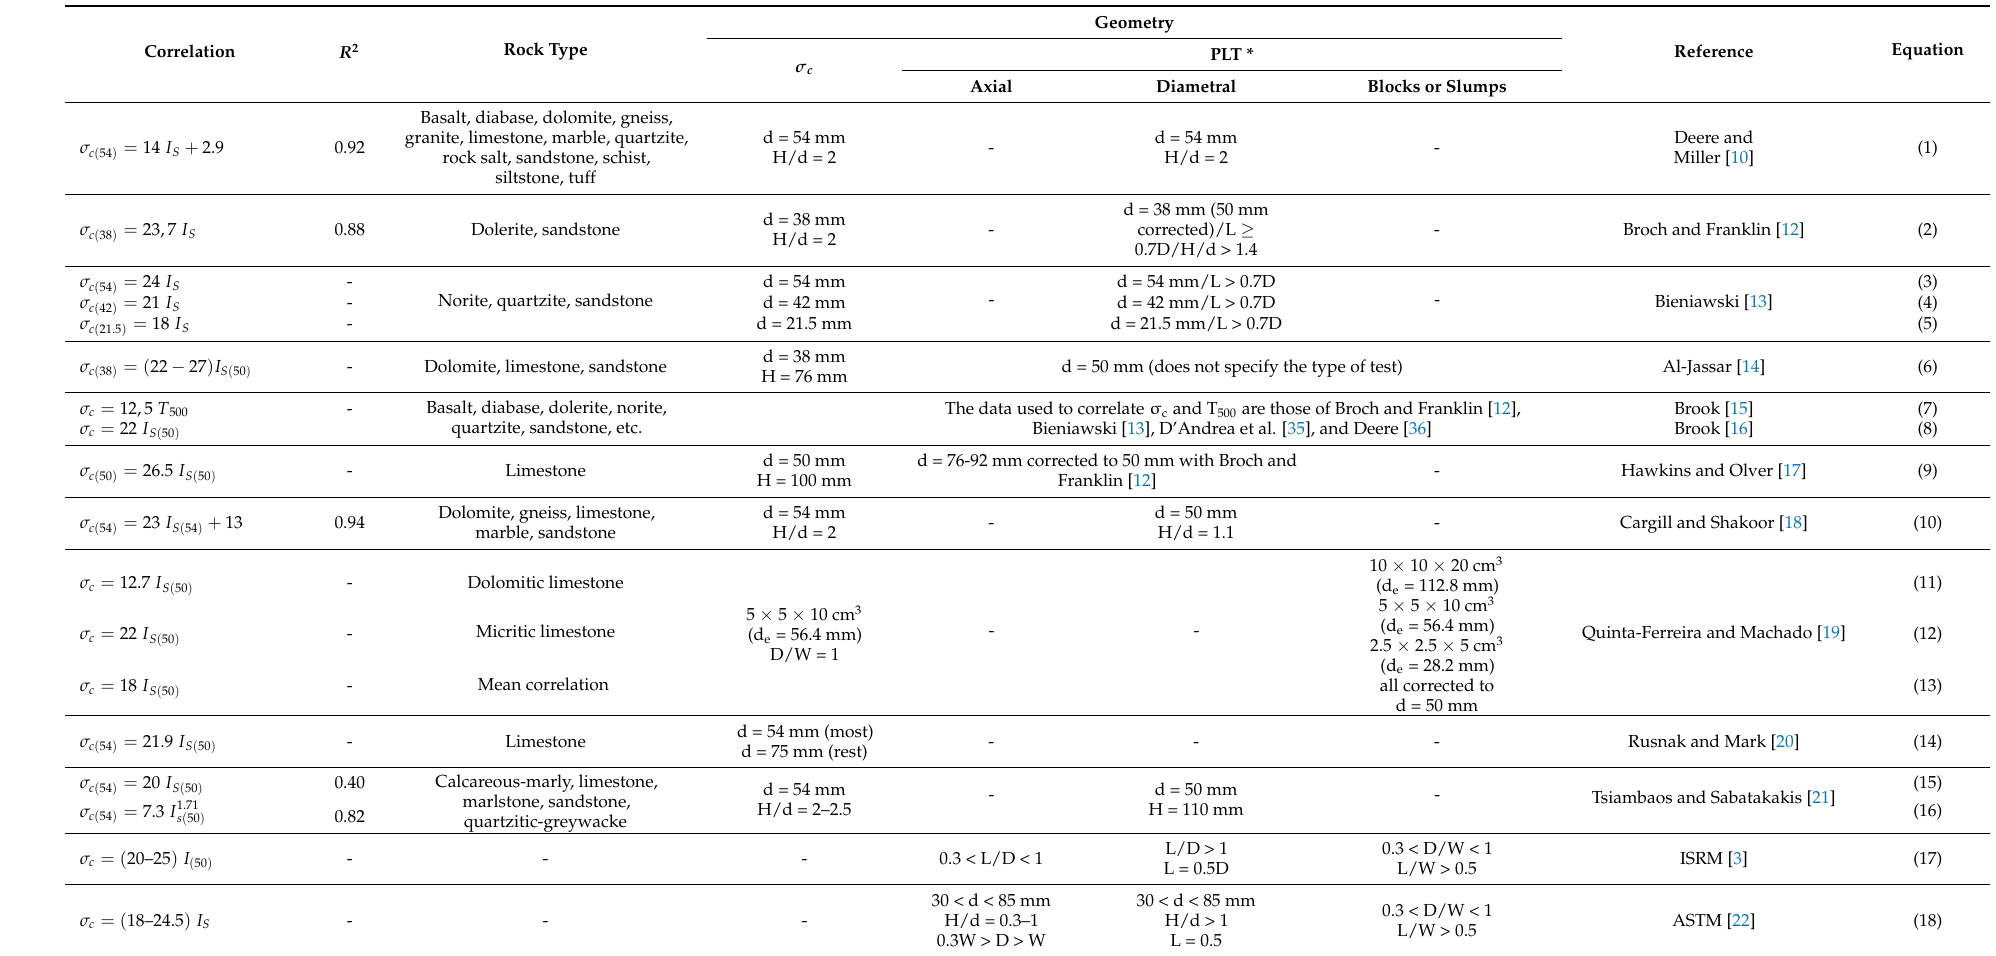
Table 1. Predictive models of uniaxial compressive strength (MPa) from point load index